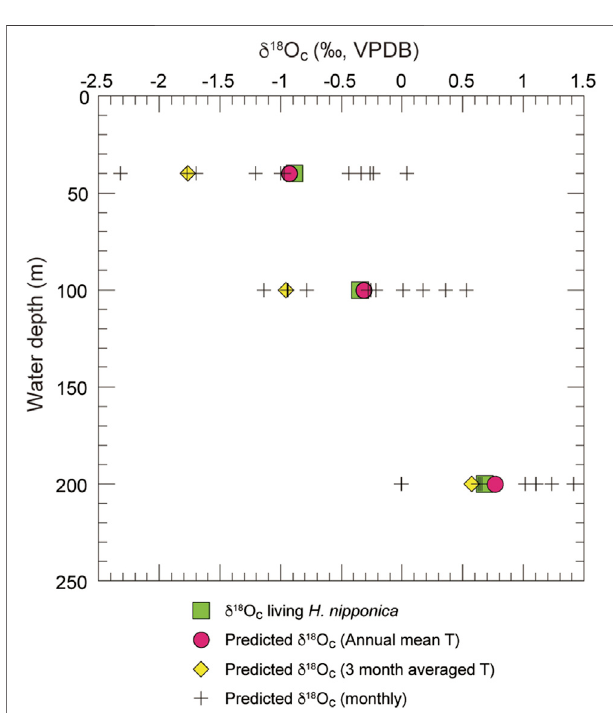
FIGURE6| Predictedandmeasured δ 18 O c ofliving H.nipponica plotted against water depth. Plus symbols show the monthly predicted δ 18 O c values atsites5(40 m),25(100 m),and26(200 m).Red fi lledcirclesandyellow fi lled diamond symbols show the predicted δ 18 O c values for annual mean temperatures and 3-months average temperature (September to November), respectively. The predicted δ 18 O c values are calculated from water temperature and δ 18 O sw in Tosa Bay using a calcite equilibrium equation (Bemis et al.,